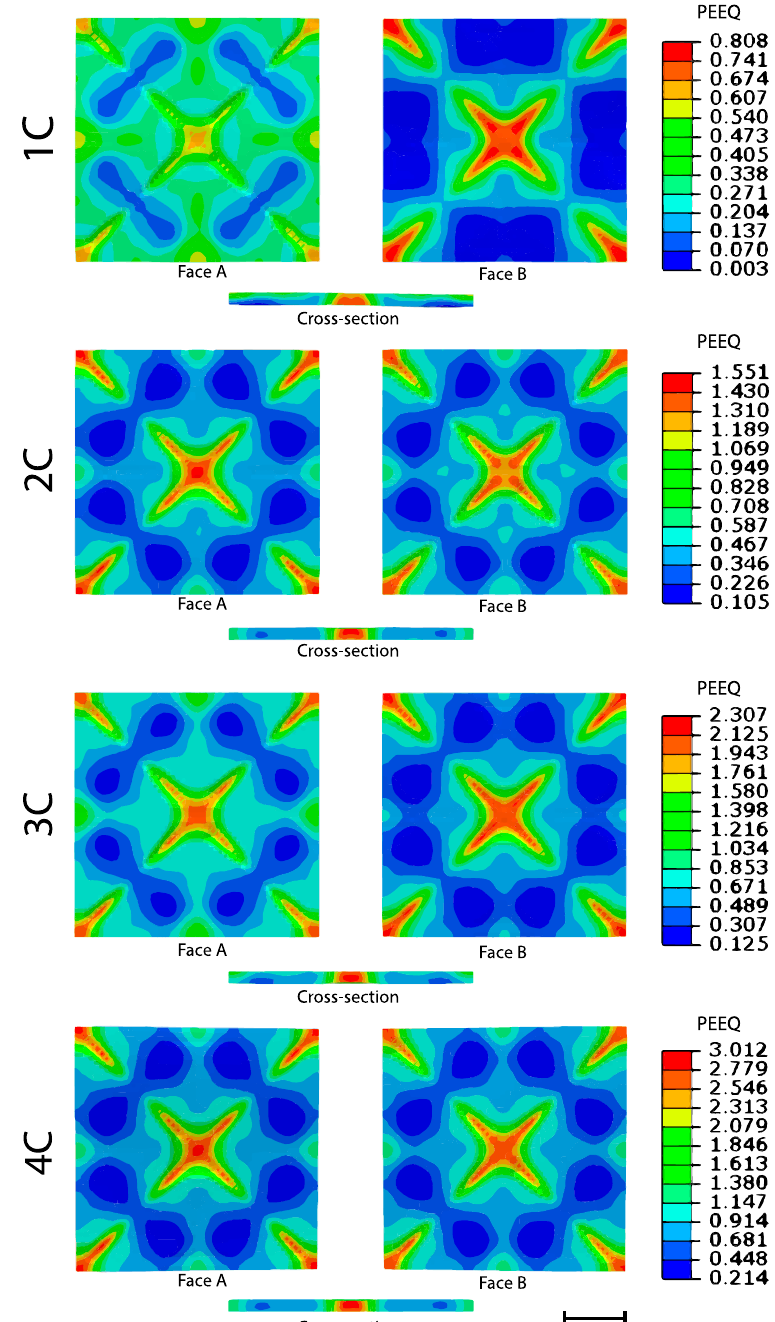
Figure 5. Equivalent plastic strain calculated by FEA simulation for one, two, three, and four cycles. The di ff erence in the equivalent plastic strain (PEEQ) contrast, between the sample upper and lower face, is rather evident.